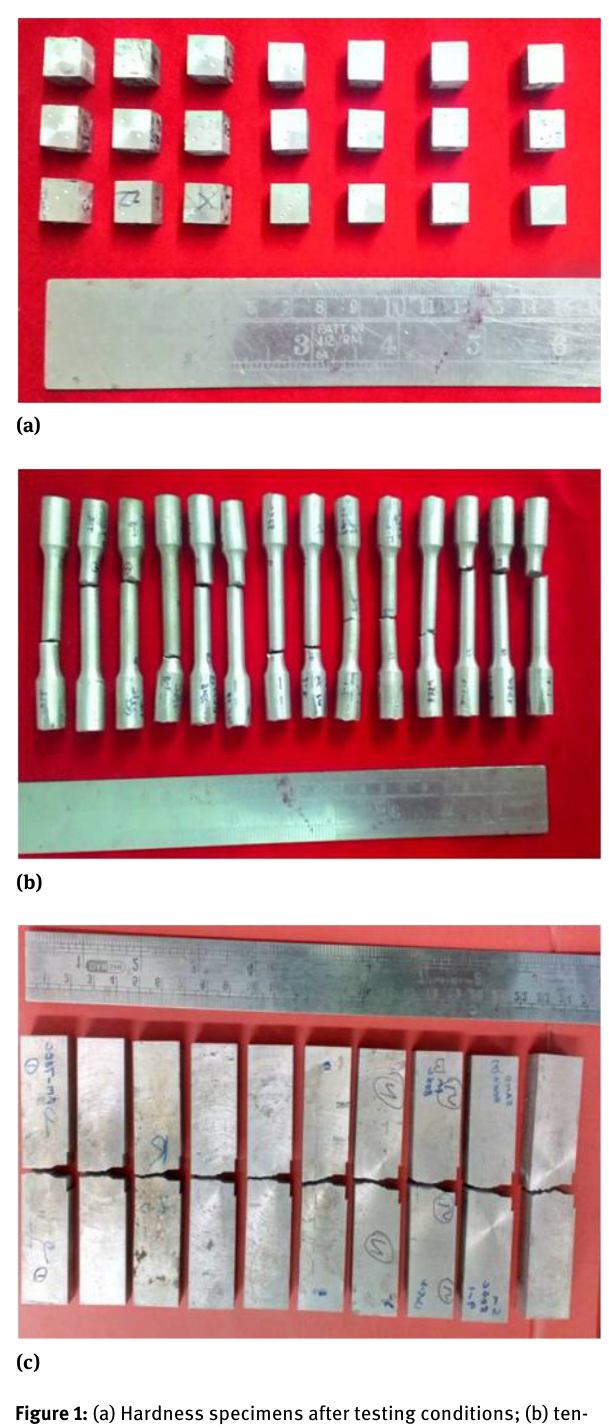
Figure 1: (a) Hardness specimens after testing conditions; (b) ten- sile specimens after testing conditions; (c) 3-point bends speci- mens after testing